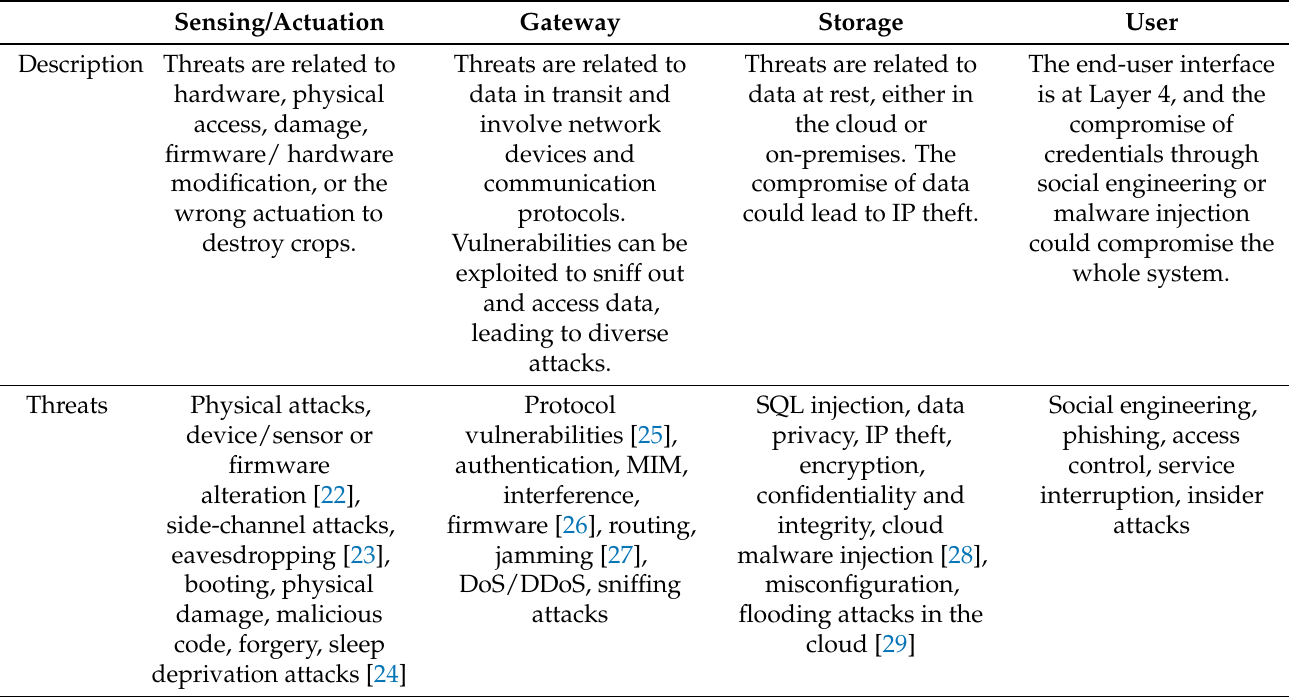
Table 1. Typical threats to digital agriculture and